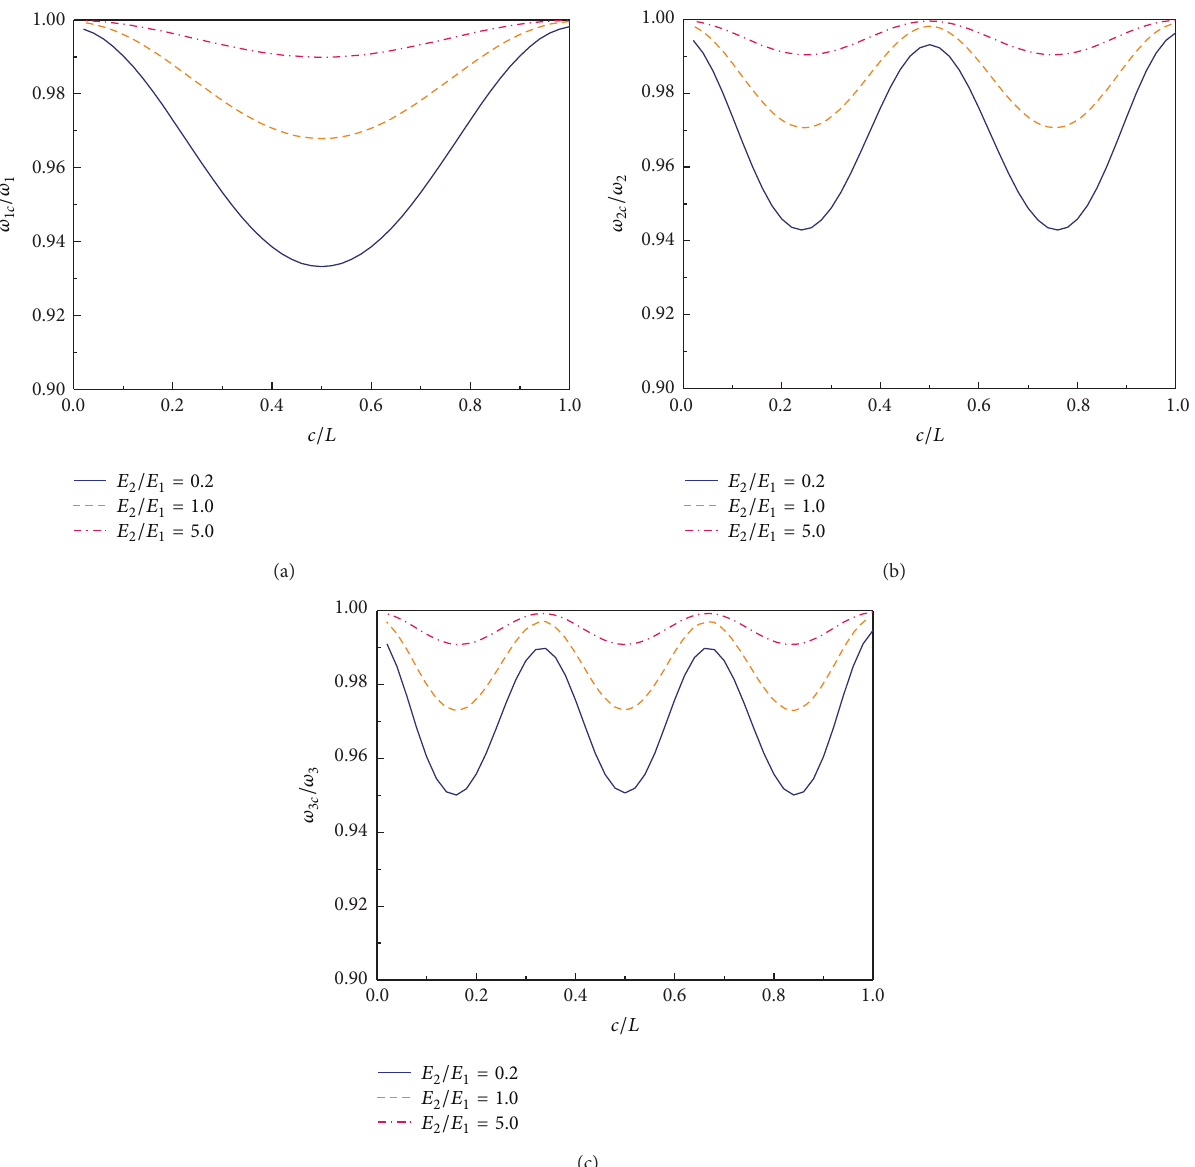
Figure 9: The first three frequency ratios of hinged-hinged FGM beams with different Young’s modulus ratios and containing a single open edge crack (𝑎/ℎ = 0.3) at varying locations: (a) the fundamental frequency ratio, (b) the second frequency ratio, and (c) the third frequency